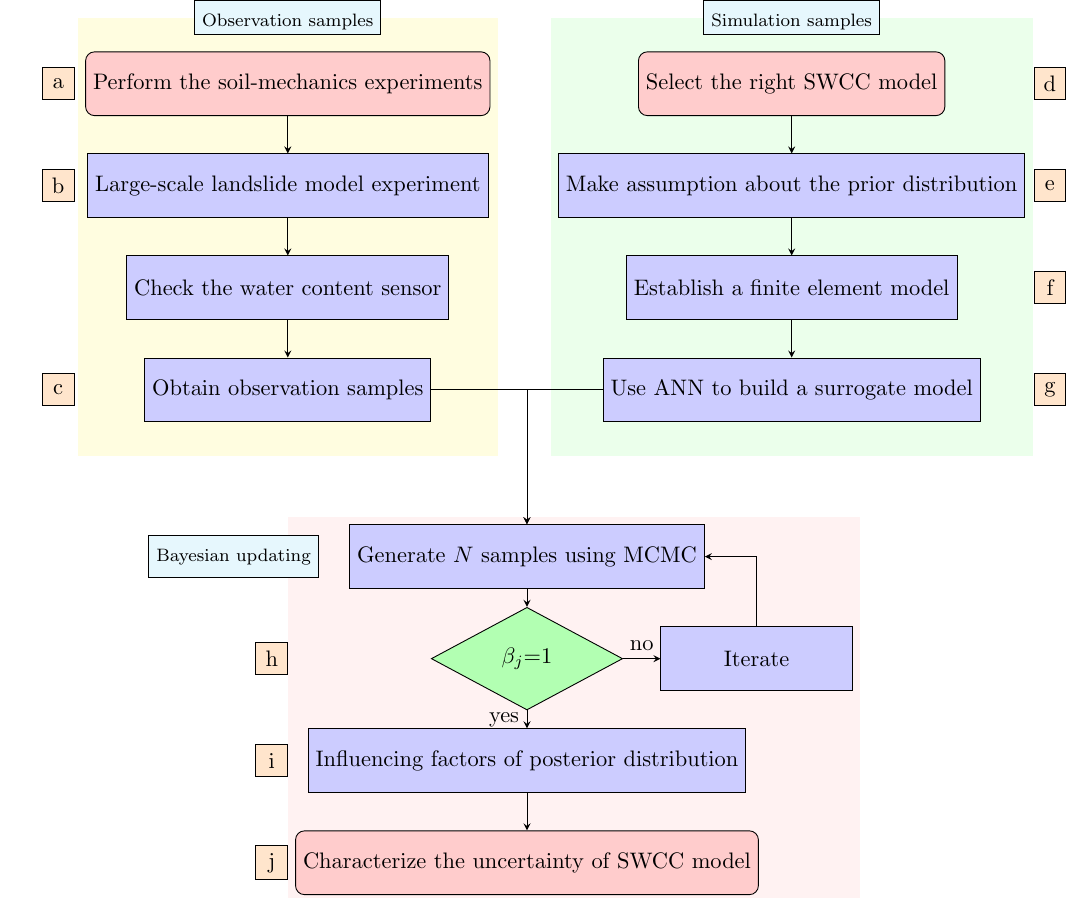
Figure 2. Flowchart of the Bayesian updating